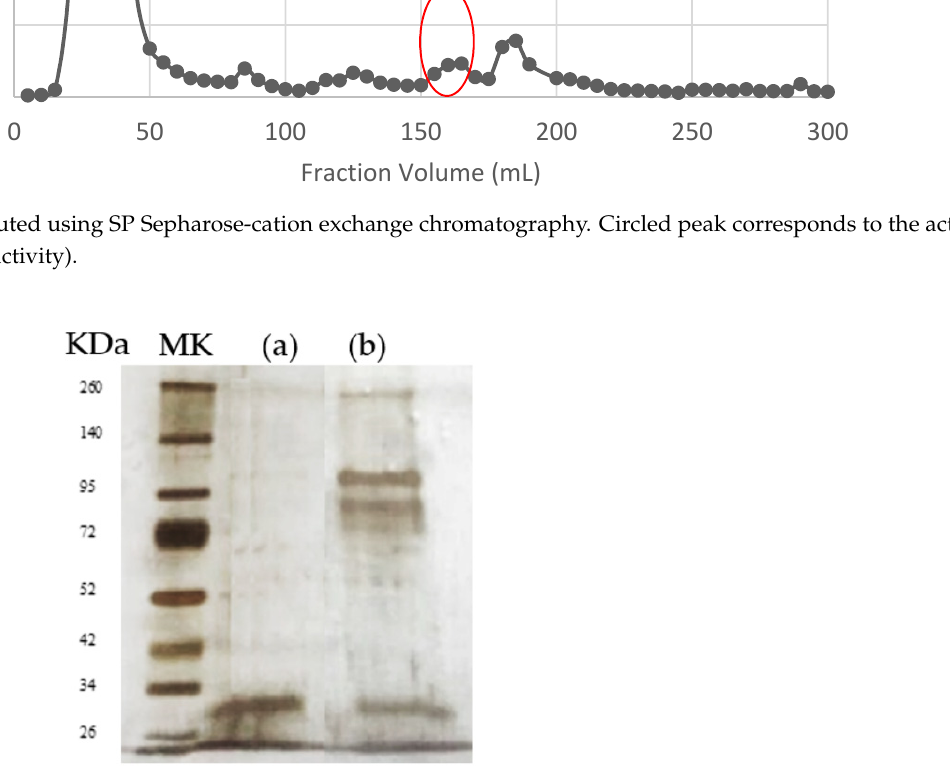
Figure 4. Signal peptide analysis graphic of consensus amino acid sequence of digested WA18 purified mycocin. 3.4. Effect of WA18 in Wine In order to evaluate WA18 antimicrobial properties related to its potential use in winemaking, the antagonistic activity against B. bruxellensis strains in wine was investigated. WA18 mycocin (PPCE, AU mL − 1 ) was tested in wine in which 9 different B. bruxellensis strains (the only survivors after five months in wine) were inoculated in sterile must and grown for 5 months. Wines treated with PPCE WA18 mycocin /700 AU L − 1 exhibited only a slight increase of phenols concentration after 60 days, around 5%, with the only exception of 212-C strain that showed a large increase of 22.6% and 66.7% of 4 ethyl phenol and 4 ethyl guaiacol, respectively (Table 5). Differently, without the mycocin, a large enhancement of 4 ethyl guaiacol was found; the trends of 4 ethyl phenol were variable and strongly linked to the strain considered. Indeed, in relation to the strains of B. bruxellensis 10-B, 14-A, 219A, 25-B and 212-C, the increase varied from a minimum of 24% to a maximum of about 880% of the initial concentration of ethyl phenols.